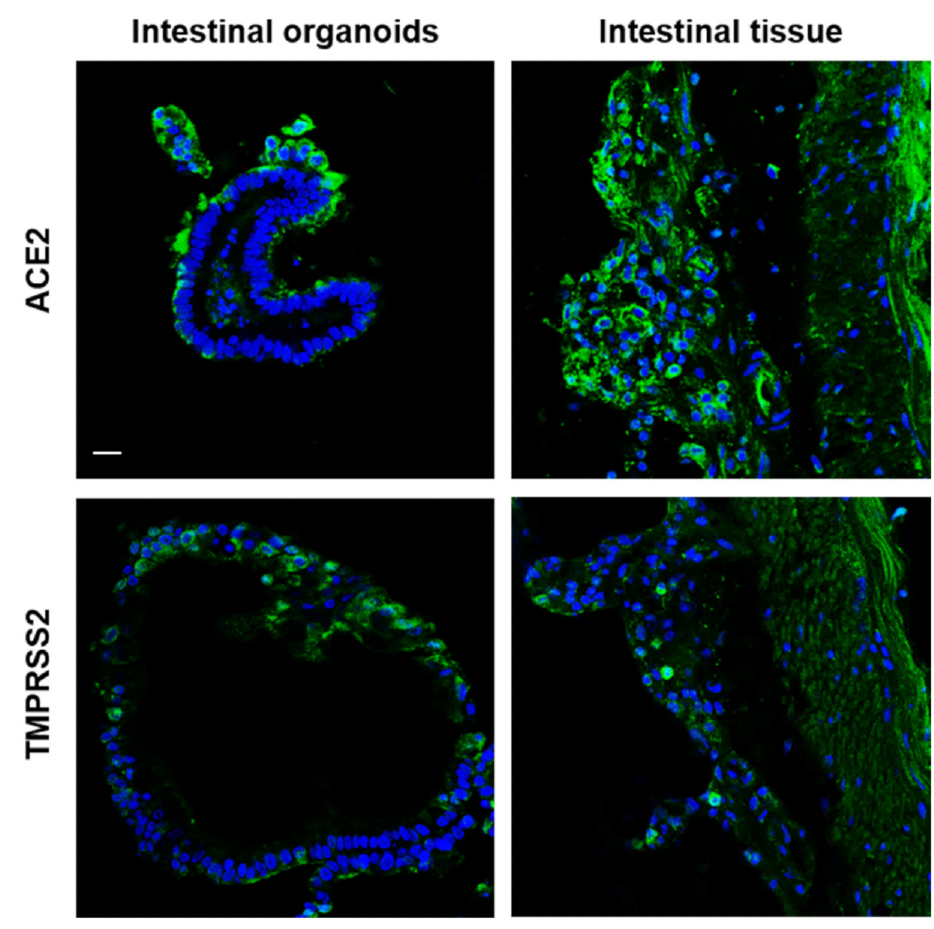
Figure 4. Localization of ACE2 and TMPRSS2 proteins in the rousette bat organoids and the bat intestine. ACE2 (green) or TMPRSS2 (green) proteins were stained using antibodies against each human homologue and merged with DAPI (blue). Scale bar: 50 µ